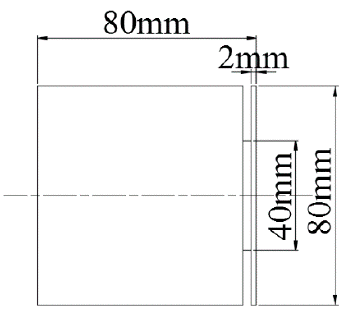
Figure 11. Workpiece diagram.